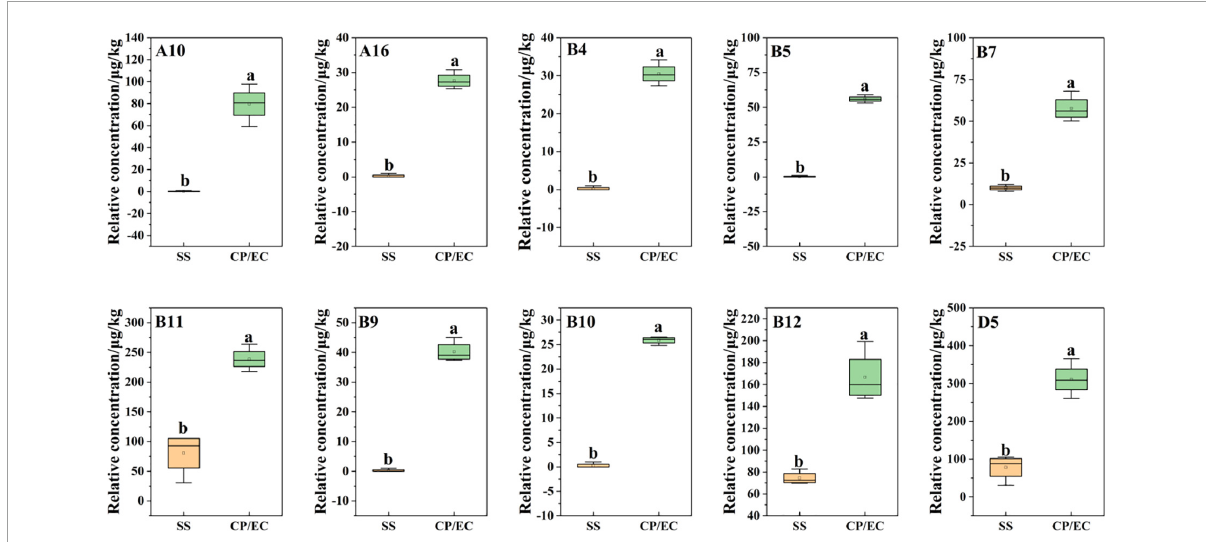
FIGURE7 Statistical analysis of differential flavor compounds related to Clitocybe squamulose chicken soup of SS vs. CP/EC group.